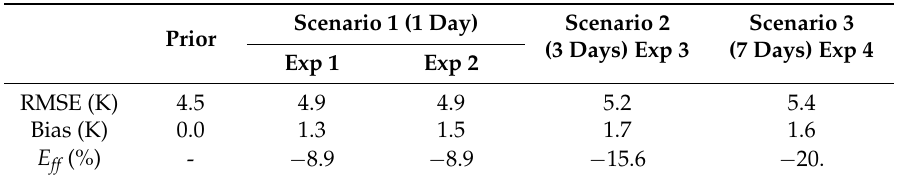
Table 5. GPS results averaged over the whole region and for the seven considered validation dates, compared to SETHYS prior estimations.